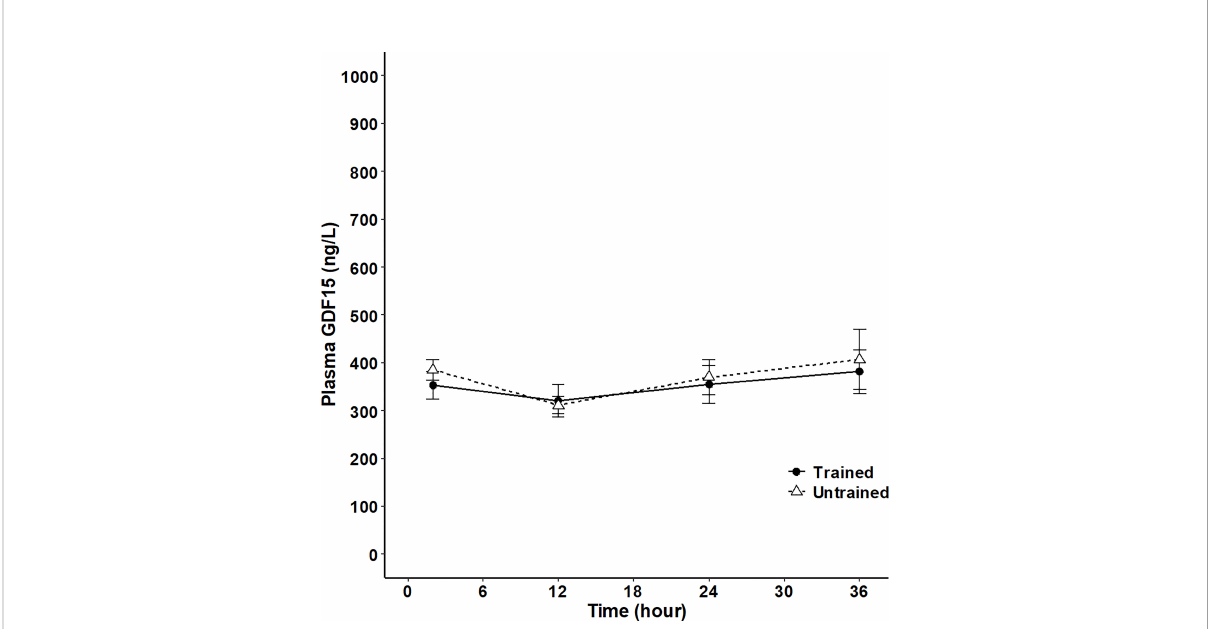
FIGURE 5 Plasma GDF15 in 8 trained (black line) and 9 untrained (broken line) healthy male subjects at 2 hours, 12 hours, 24 hours and 36 hours after a standardized meal. (Two-way ANOVA: Time P<0.0377, Group P=0.7864, TimexGroup P= 0.9320). Data are presented as means +/-